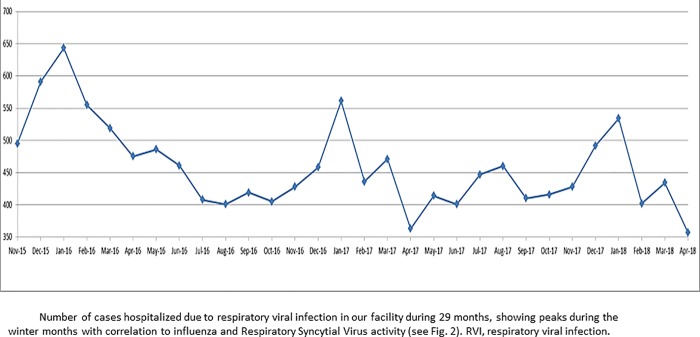
Number of hospitalizations due to RVI in 3 winter seasons.